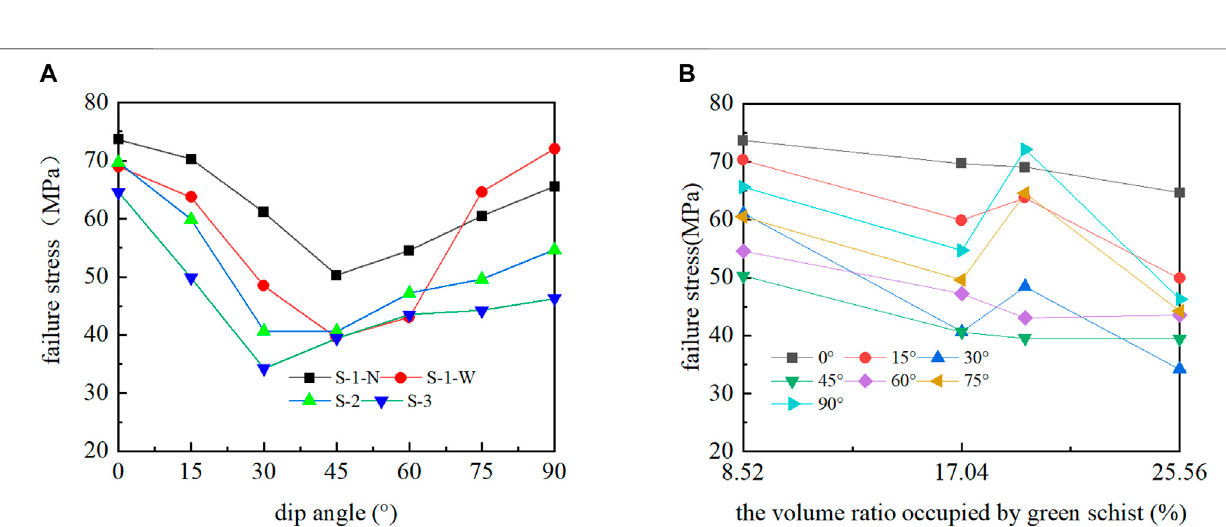
Frontiers in Earth Science |